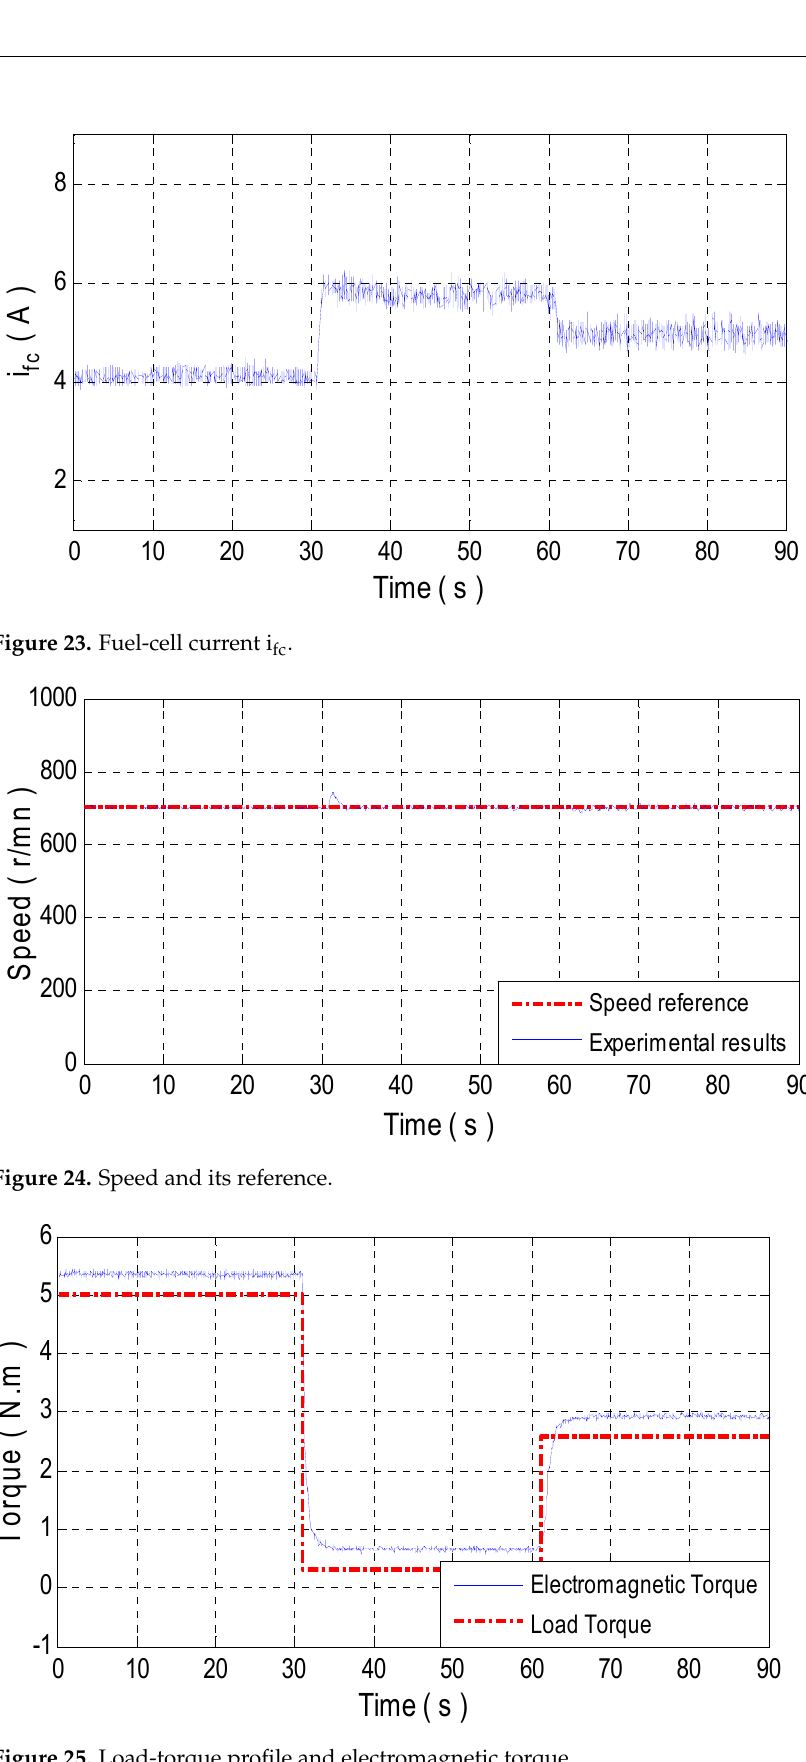
Figure 25. Load ‐ torque profile and electromagnetic torque.